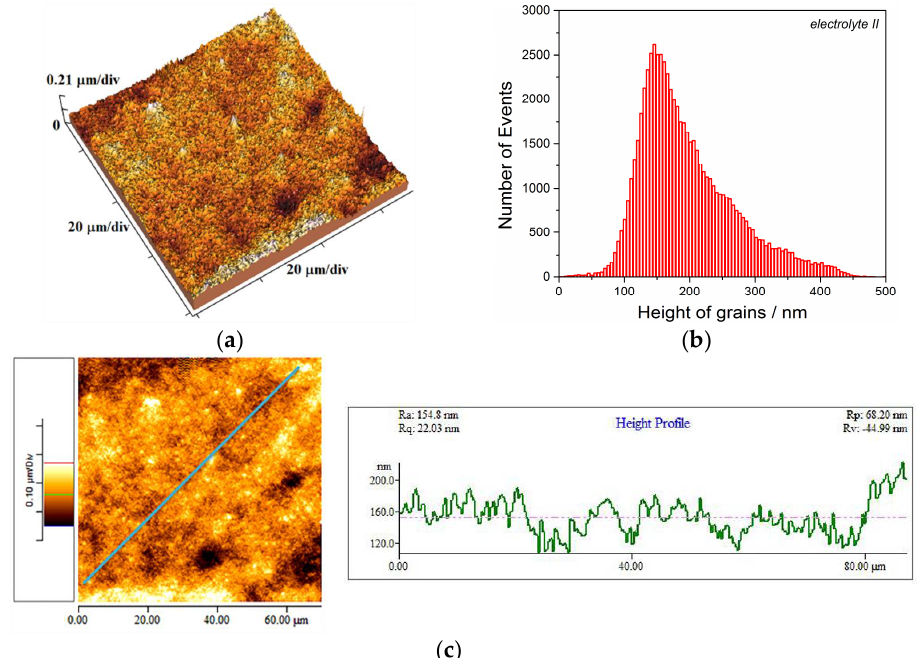
Figure 3. The AFM analysis of 20 µ m thick Cu coating obtained by electrodeposition at a current density of 50 mA cm − 2 on the brass from electrolyte II : ( a ) the surface topography, ( b ) the histogram and ( c ) line section analysis (X-axis: distance line; Y-axis: height profile). Scan size: (70 × 70) µ m 2